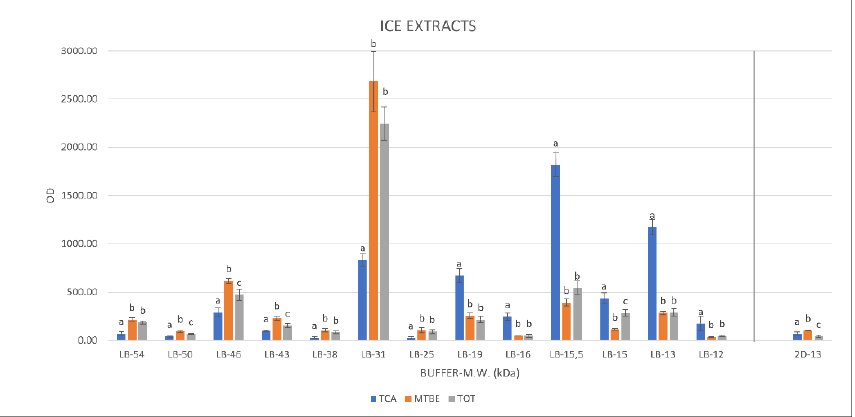
Figure 3. Histogram representing the optical density (mean ± standard deviation), of SDS-PAGE protein bands with at least 2-fold differences among ICE extracts obtained with TCA, MTBE and TOT methods. The grey vertical bar divides LB1X-R (left side) from 2D-buffer solubilized samples (right side). Significant different values ( p -value < 0.05) are indicated by different letters.